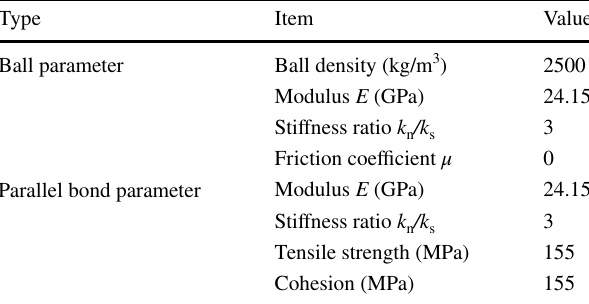
Table 2 Microscopic parameter values of parallel bonding